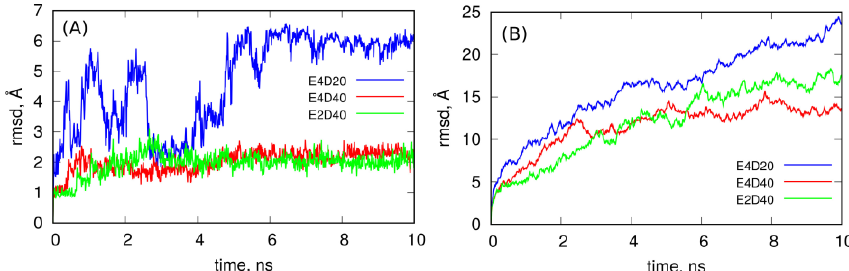
Figure 5. ( A ) Root of mean squared displacement, rmsd, determined for DOX molecules encapsu- lated in the nanotube interior and ( B ) rmsd of the whole systems both obtained from the last 10 ns of